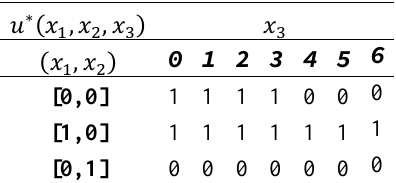
Table 1. Optimal production policy: s=1, K=0